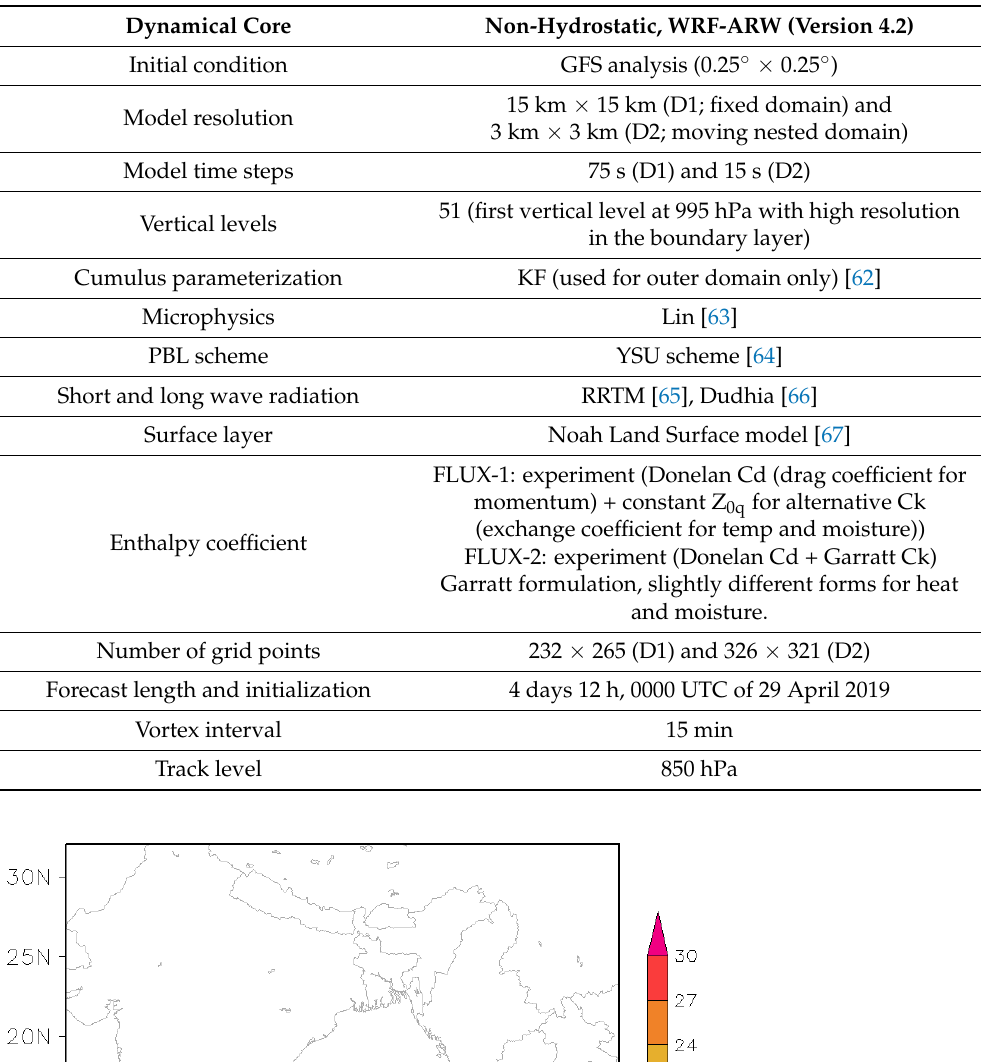
Table 1. WRF Model configuration used in the study.